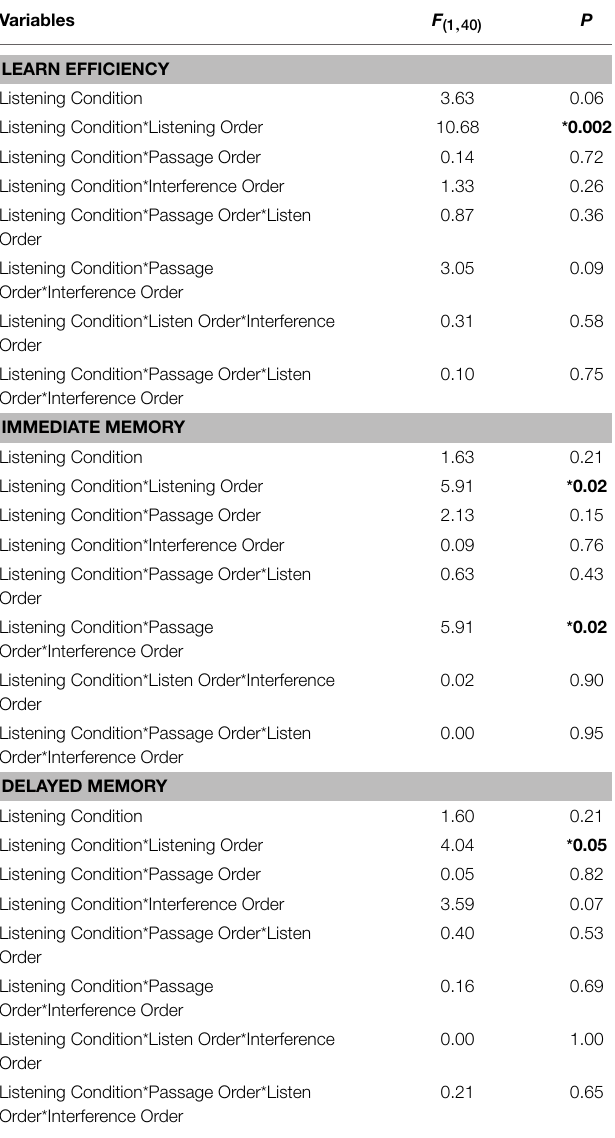
TABLE 5 | Order of Experimental Effects and Interactions.